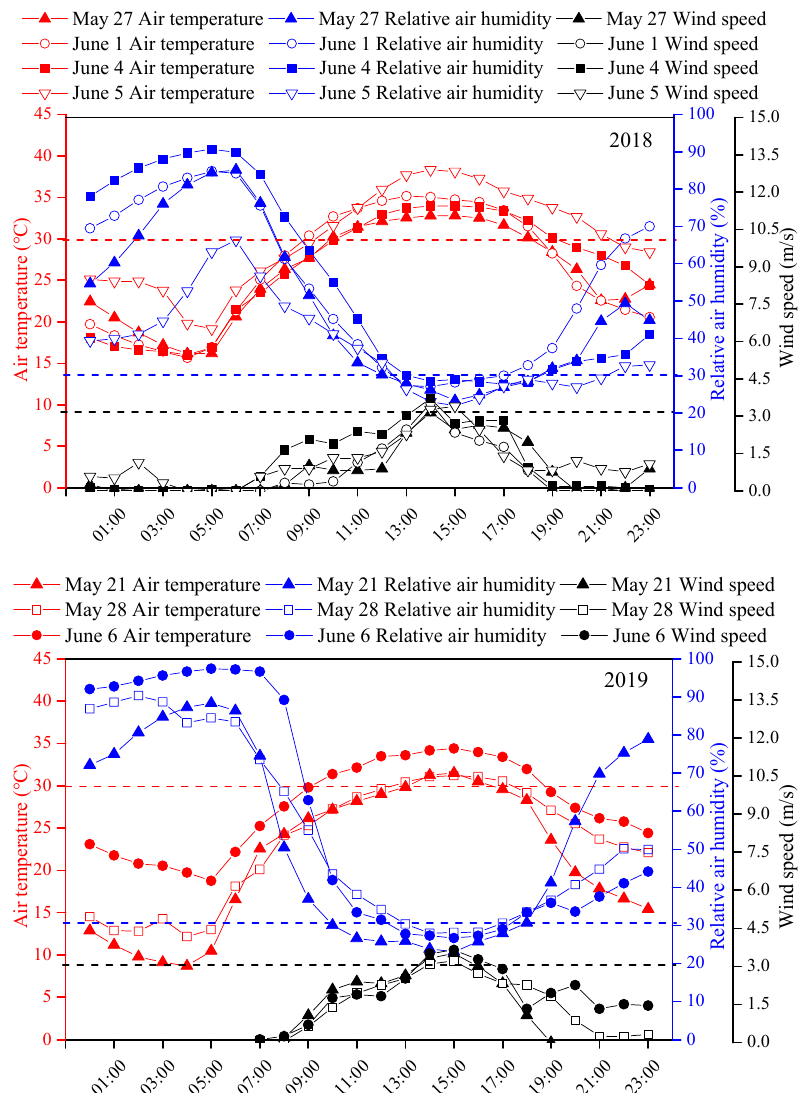
Figure 3. Air temperature, relative air humidity, and wind speed corresponds to the days when dry-hot wind occurred in the 2018 and 2019 seasons.